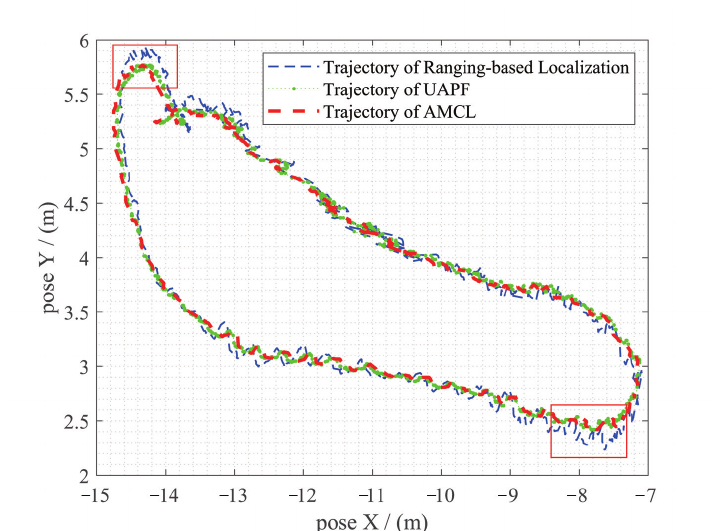
Figure 13. Trajectories of ranging-based localization, UAPF and AMCL. In general, the three have similar performance in accuracy. The two red rectangles show that UAPF could correct the instability of ranging-based